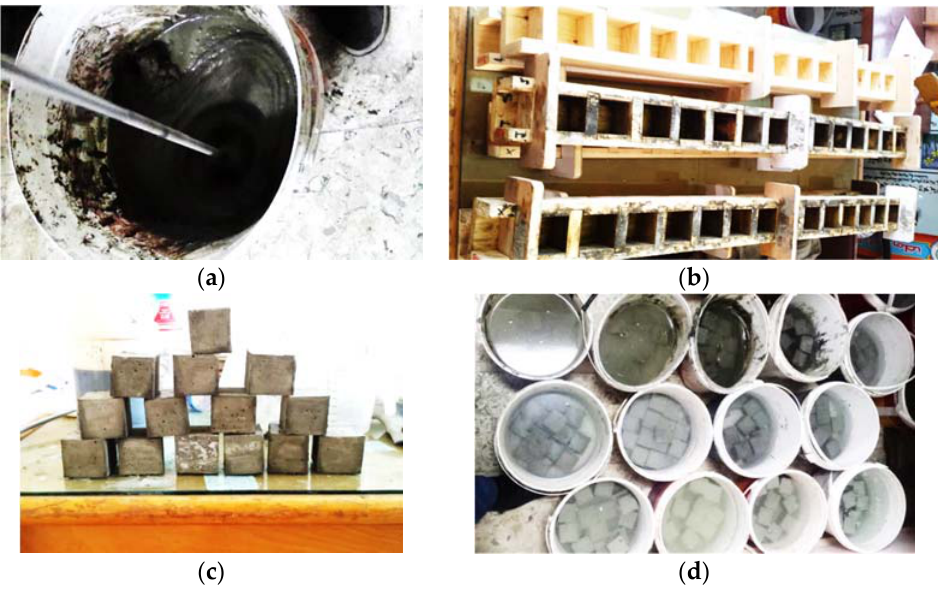
Figure 5. Mixing process. ( a ) Mortar mixing; ( b ) Wooden forms; ( c ) Demolded mortar samples; ( d ) Mortar specimens curing.